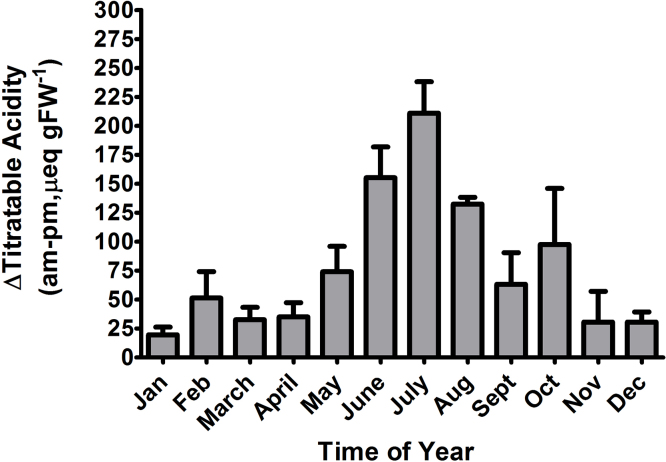
The monthly average change of titratable acidity (AM- PM) of well-watered Portulacaria afra plants grown in Southern California in the Northern Hemisphere. Summer months are June, July, and August. (n = 4-9, error bars indicate 1 SEM). Data is taken from Guralnick (1983) and Guralnick (1987).